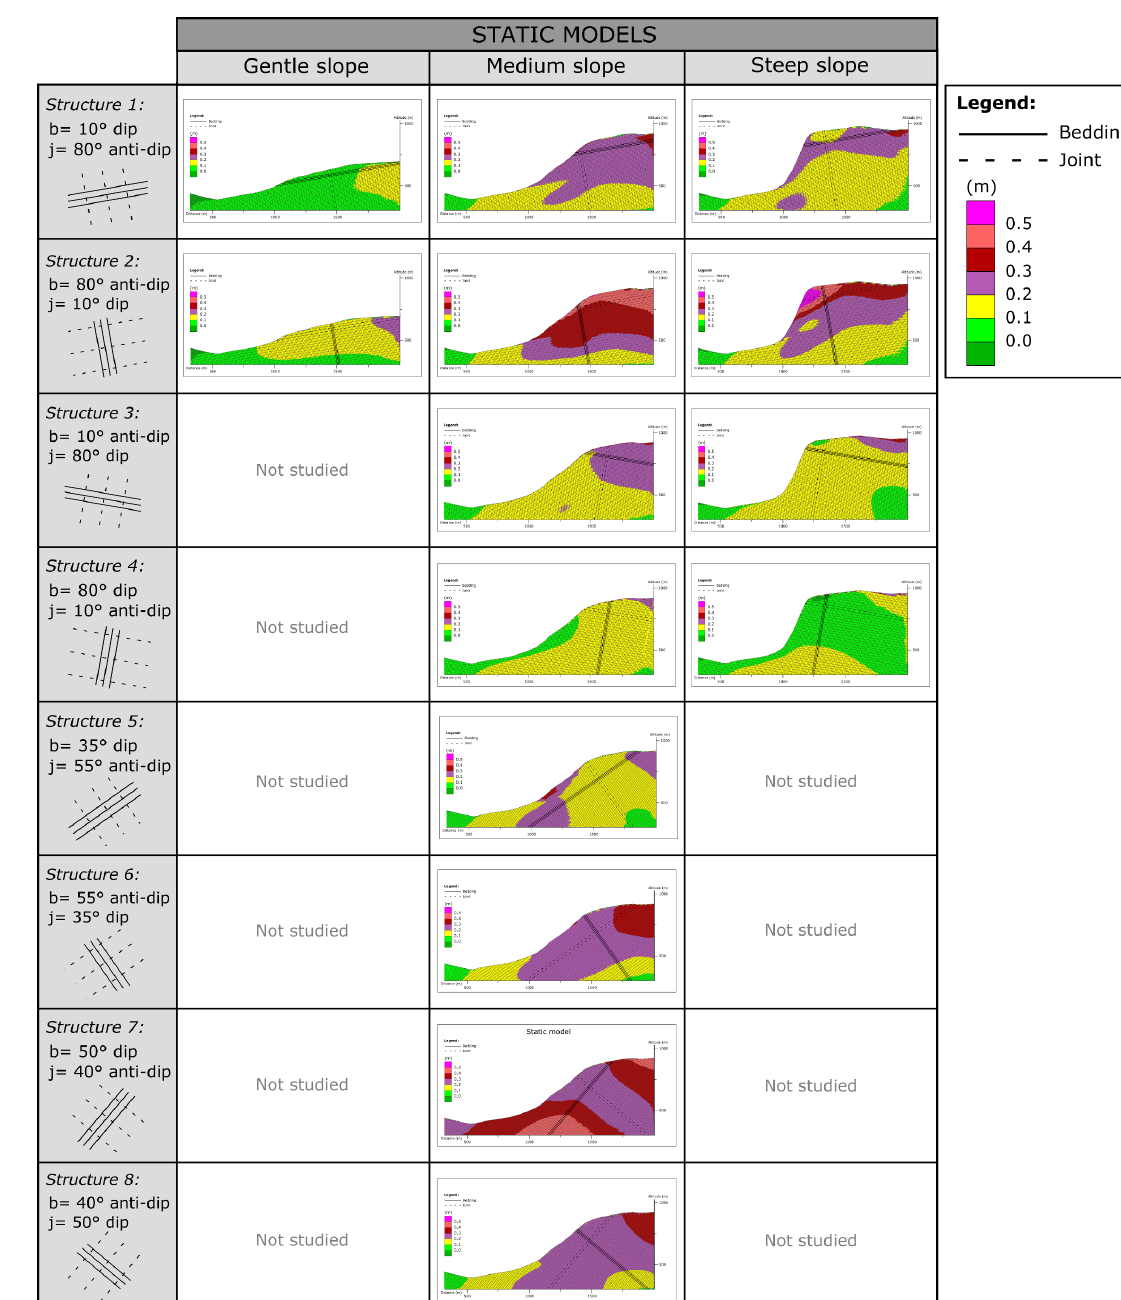
Figure 14. Static modelling results in terms of displacements for the three rock slope